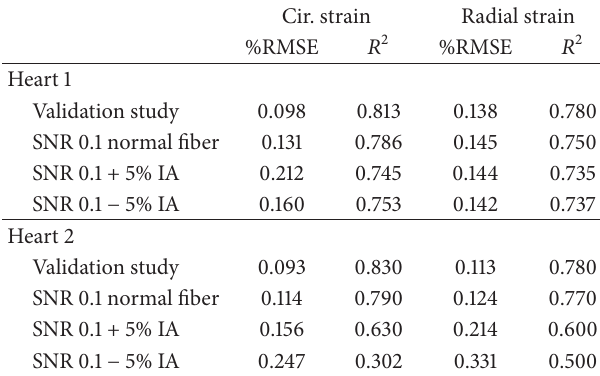
Table 3: Effect of changes in fiber distribution on the active contraction component alone for Hearts 1 and 2. Changes in inclination angle had a direct effect upon the strain predictions for the SNR 0.1 cases, particularly in the circumferential direction strain